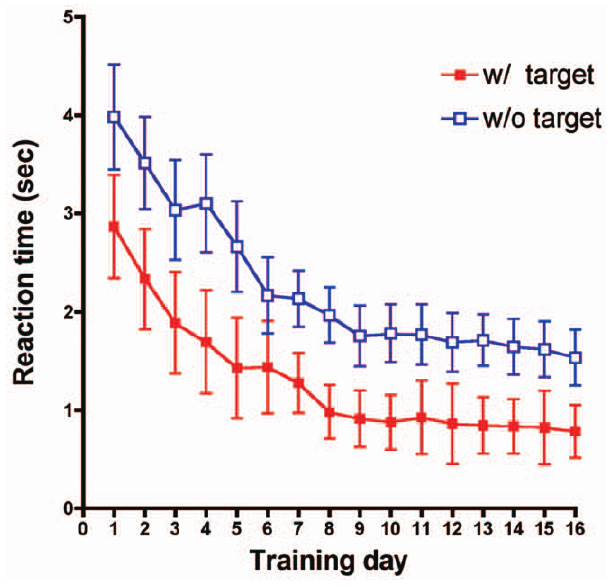
Reaction time in seconds as a function of training day is plotted. Filled red squares denote the data when the target is presented. Blank blue squares denote when the target is absent. The data from 12 subjects are averaged. Error bars represent 6 1SEM.